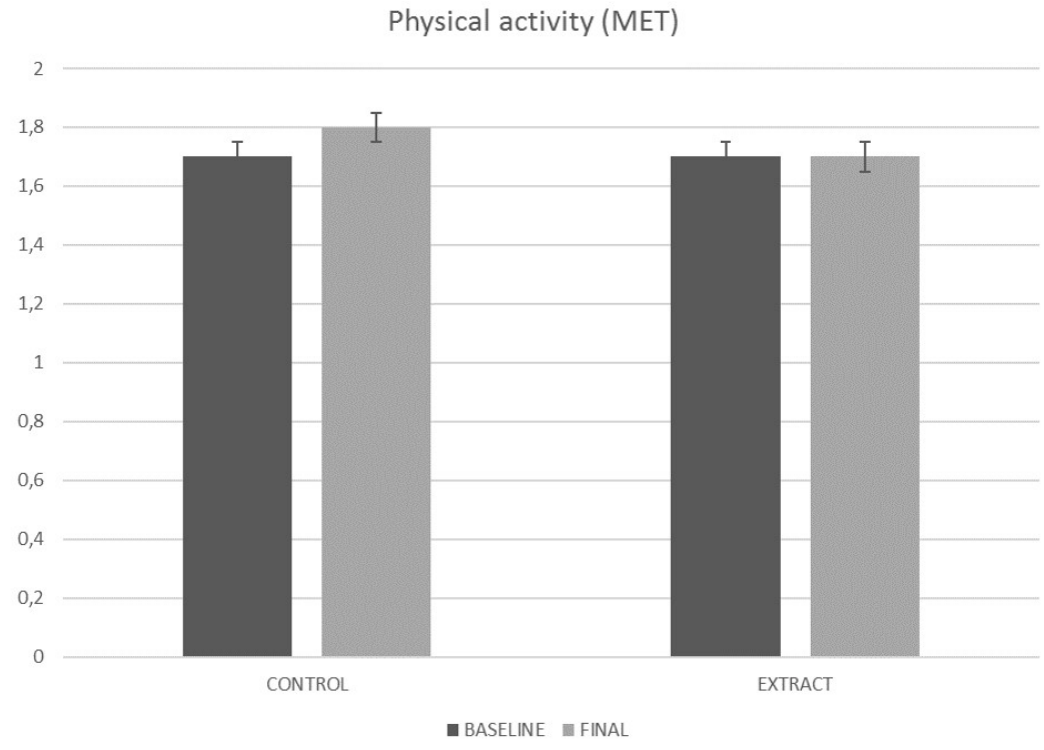
Figure 5. Physical activity EVOLUTION along the study. MET, metabolic equivalent of task.